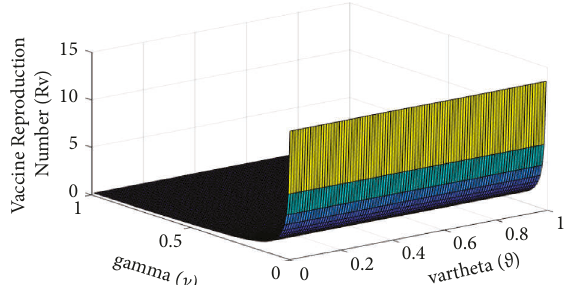
Figure 5: Plot of the vaccine reproduction number R rate of vaccination ( c ) and vaccine efficacy ( ϑ )